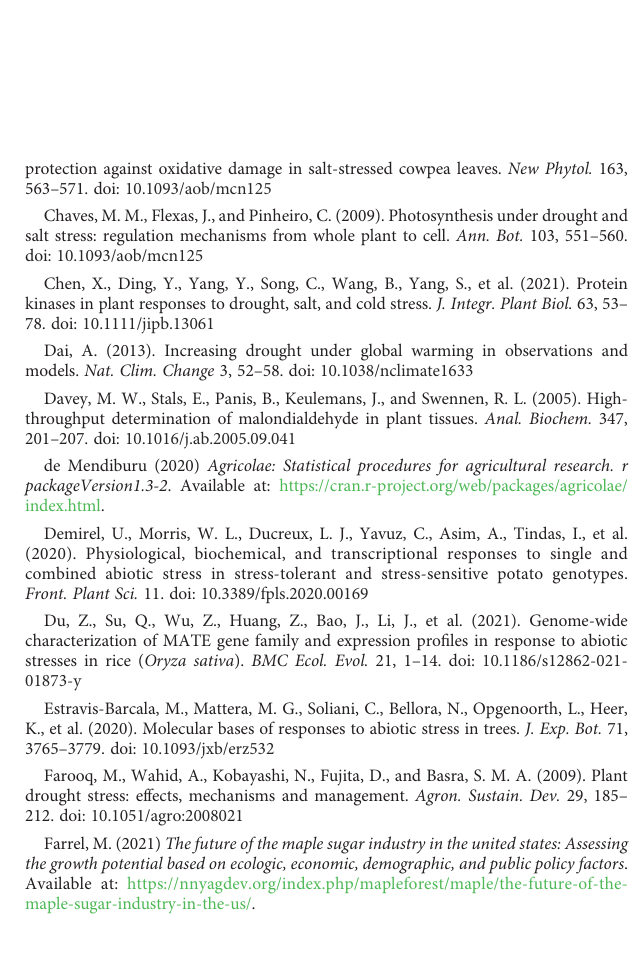
SUPPLEMENTARY TABLE 3 Summary of RNAseq and mapping analysis. SUPPLEMENTARY TABLE 9 GO enrichment